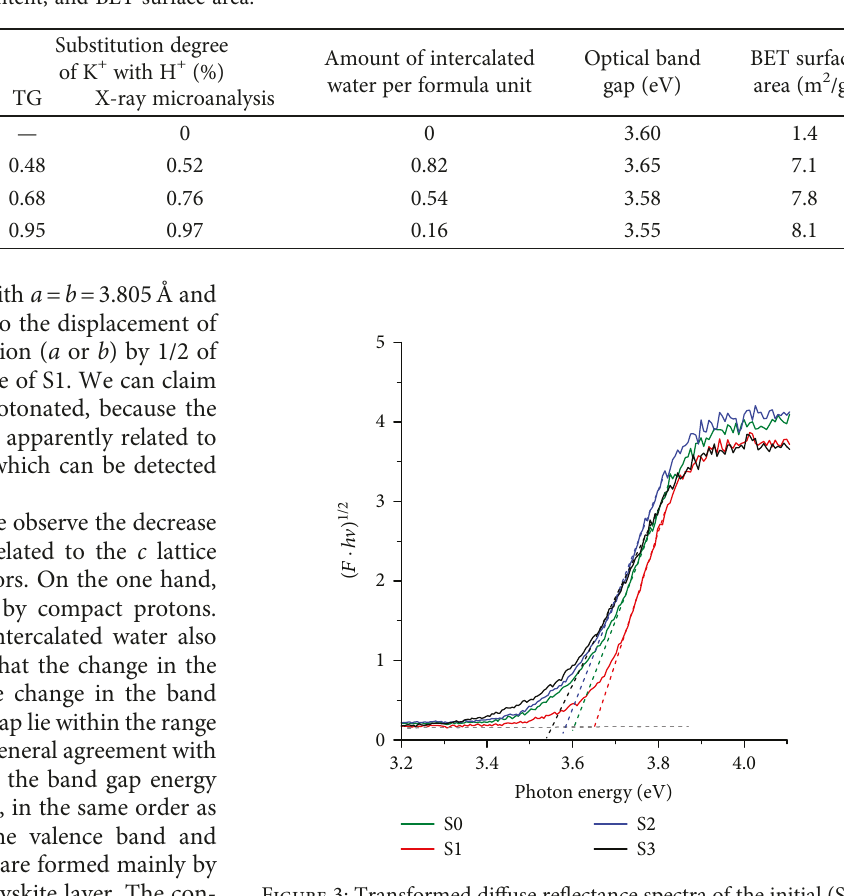
La Ti O 2 2 3 10